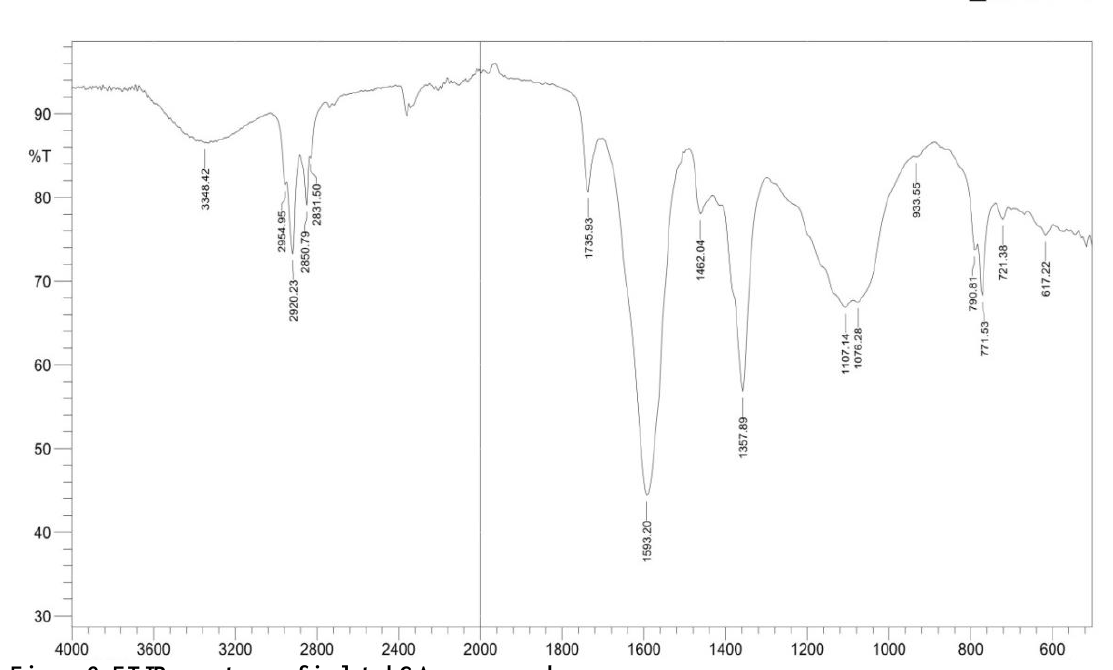
Figure 9. FTIR spectrum of isolated CA